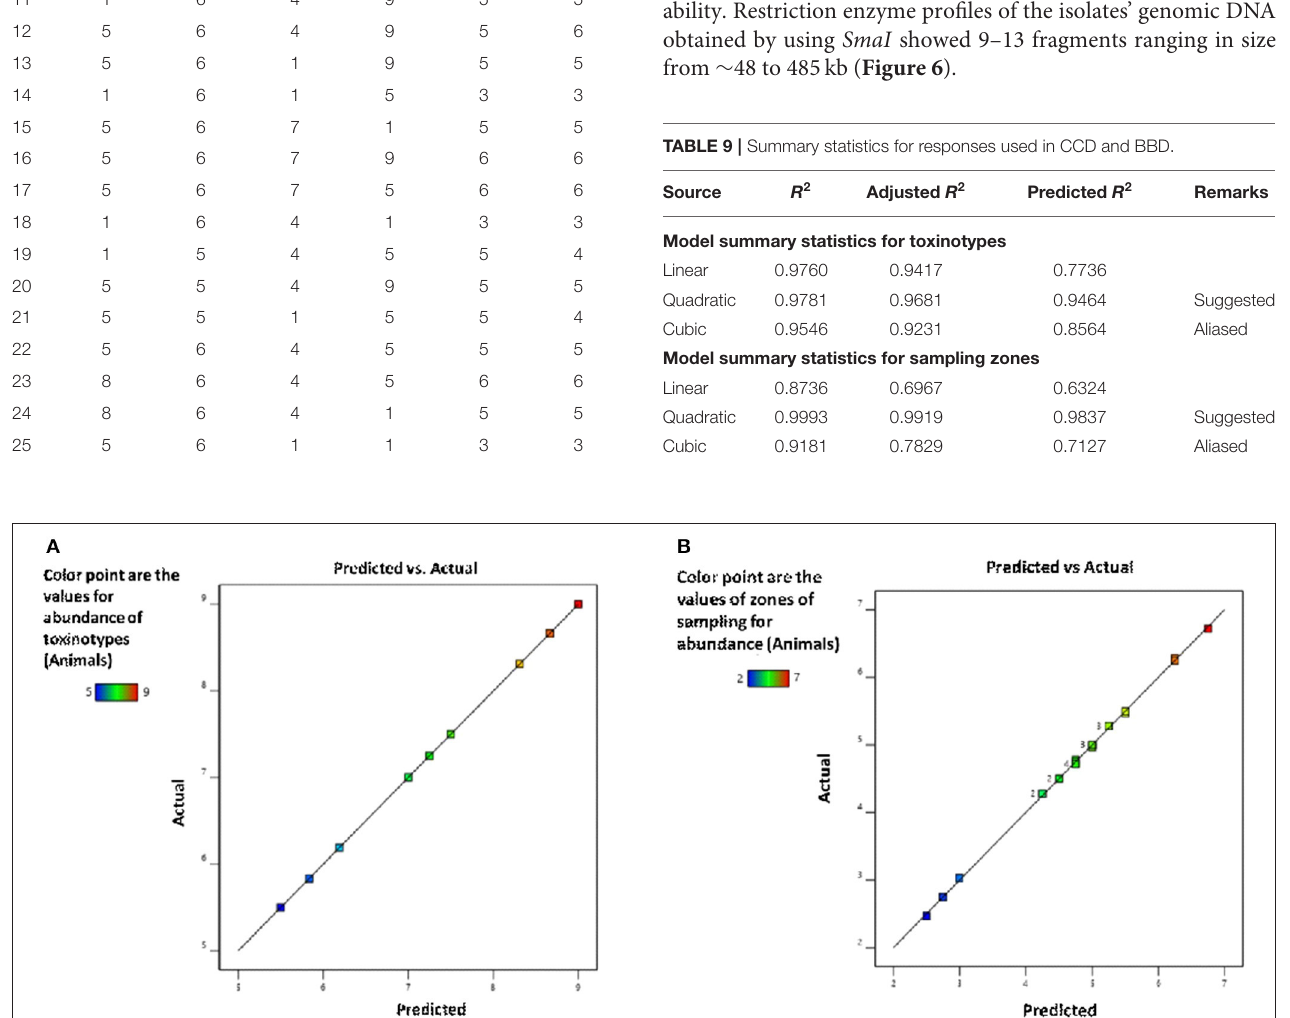
Frontiers in Veterinary Science |